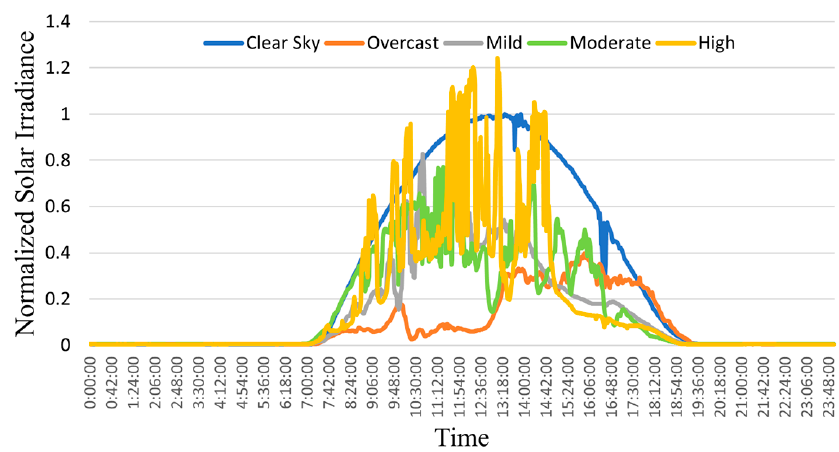
Figure 4. PV generation profiles for five di ff erent solar variability types.